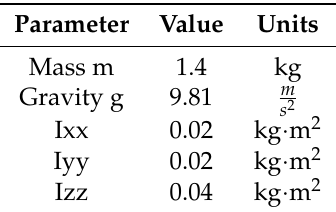
Table 1. Model Parameters.